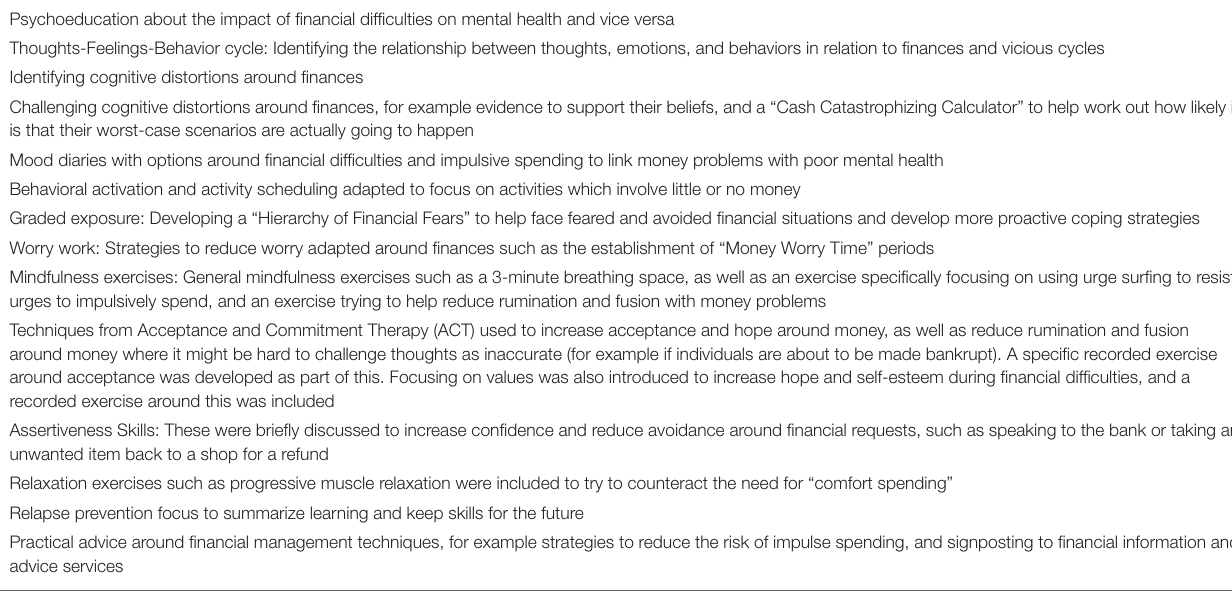
TABLE 2 | Description of specific therapy techniques used in space from money worries.